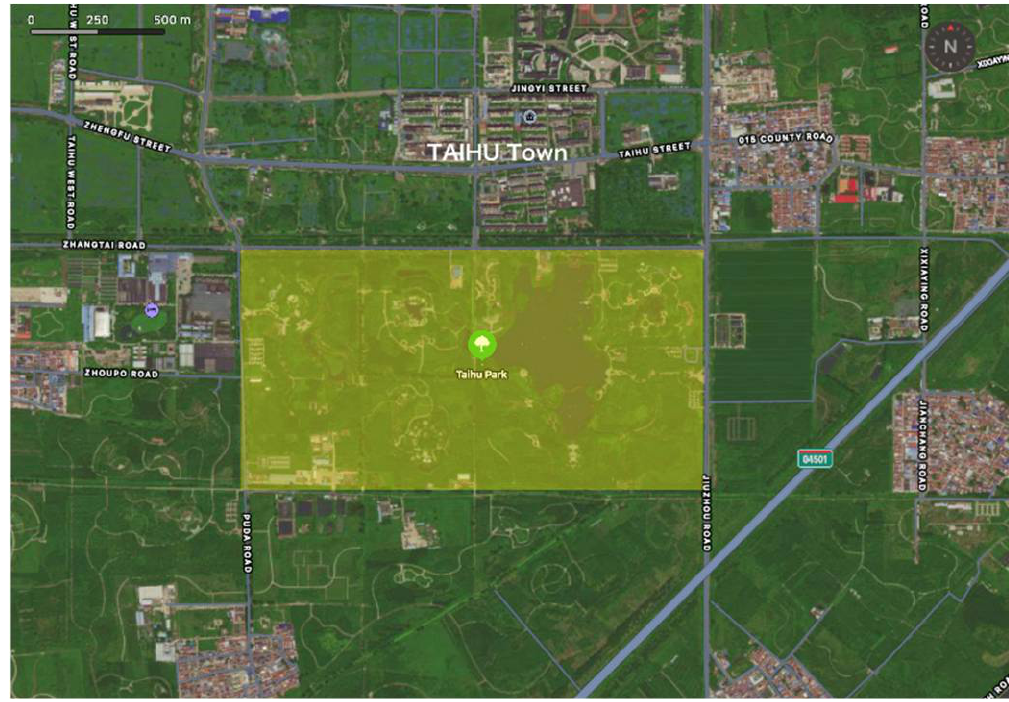
Figure 1. Location of Taihu Town (Beijing, China). Taihu Park is one of the landmark attractions in Taihu Town (Figure 2). Taihu Park is located in the southwest corner of the intersection of Jiuzhou Road and Zhangtai Road, Tongzhou District, Beijing, covering an area of about 147 hectares (Figure 3). It is one of the large-scale greening projects in the sub-center of Beijing city. Many landscapes are set up in the park, forming twelve characteristic scenic spots including: “Taihu Xiagang”, “Hongqiao Fish Music”, and “Gaotai Qiubo”. Taihu Park has been open to tourists since July 2014. In the early stage, it only provides recreational activities without any paid en- tertainment items. It is a public welfare rural country park. As the park gradually opened and the number of tourists increased, the campus management and maintenance came under certain pressure. Considering the demand for entertainment, the unit of the man- agement began to provide tourists with a cruise ship and bike rental to choose from, and opened the visitor center, providing reading, a rest area, and creating other products to buy . At present, there are no other income-generating projects and the maintenance and management of trees in the park is still the main work content. Figure 2. Location of Taihu Park in China.